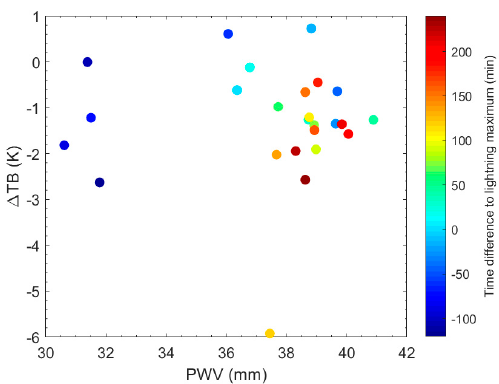
Figure 11. Scatterplot of ∆ TB with respect to PWV as a function of time difference with respect to the main lightning activity.